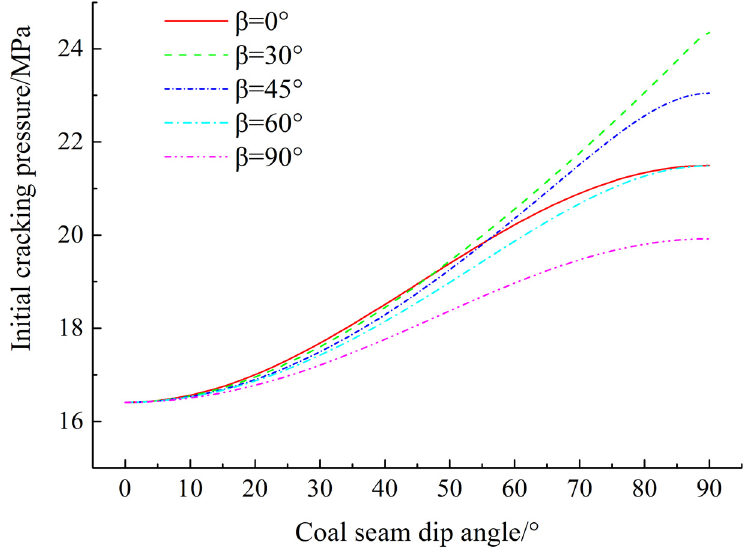
Figure 11. Relationship between the initial cracking pressure and coal seam dip